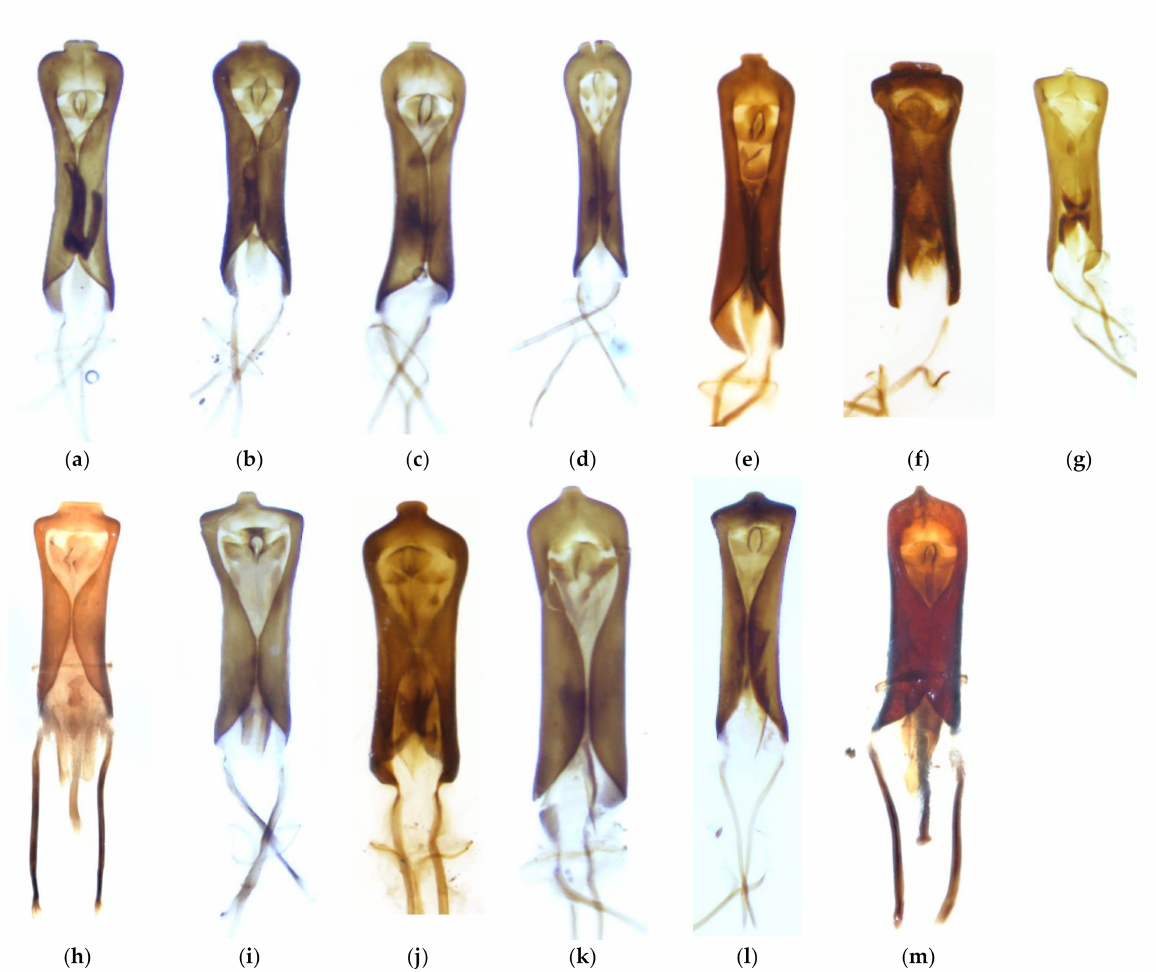
Figure 2. Aedeagal sclerites of the 13 Gonipterus species identified. Aedeagi of the G. scutellatus cryptic species complex ( a – e ). Gonipterus species phylogenetically grouped with the G. scutellatus species complex ( f – j ). Gonipterus species not part of the G. scutellatus cryptic species complex ( k – m ). ( a ) Gonipterus sp. n. 1; ( b ) Gonipterus sp. n. 2; ( c ) Gonipterus sp. n. 3; ( d ) Gonipterus sp. n. 4; ( e ) G. pulverulentus; ( f ) Gonipterus sp. n. 6; ( g ) Gonipterus sp. 12; ( h ) Gonipterus sp. n. 7; ( i ) Gonipterus sp. 10; ( j ) Gonipterus sp. 11; ( k ) Gonipterus sp. 8; ( l ) G. notographus; and ( m ) G. cinnamomeus